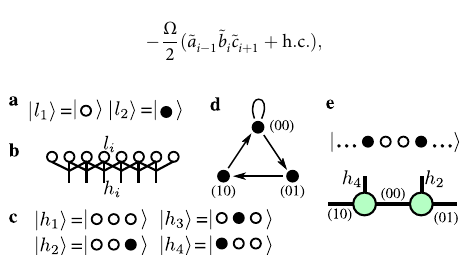
(cid:9) (cid:10) (cid:9) . The